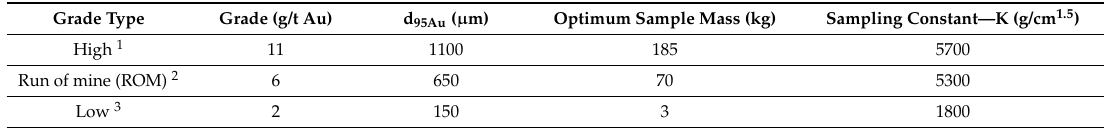
Table 2. Optimal sample mass required to achieve theoretical “field” precision of ± 20% at the 90% confidence limits for different grade-liberation diameter scenarios within the